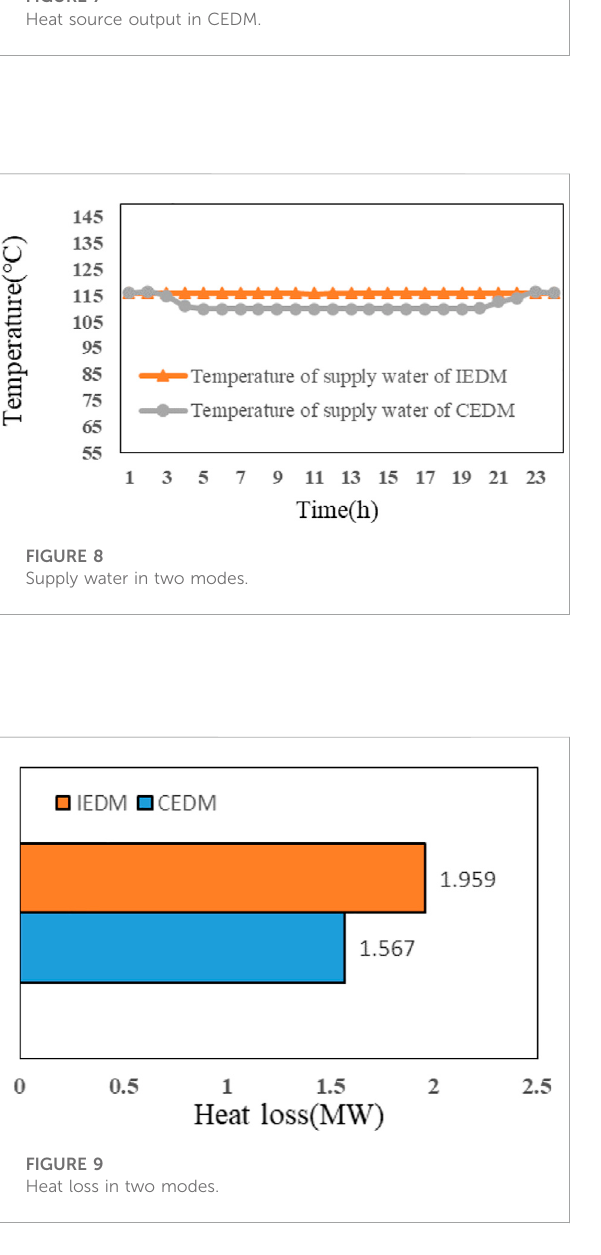
FIGURE 7 Heat source output in CEDM.